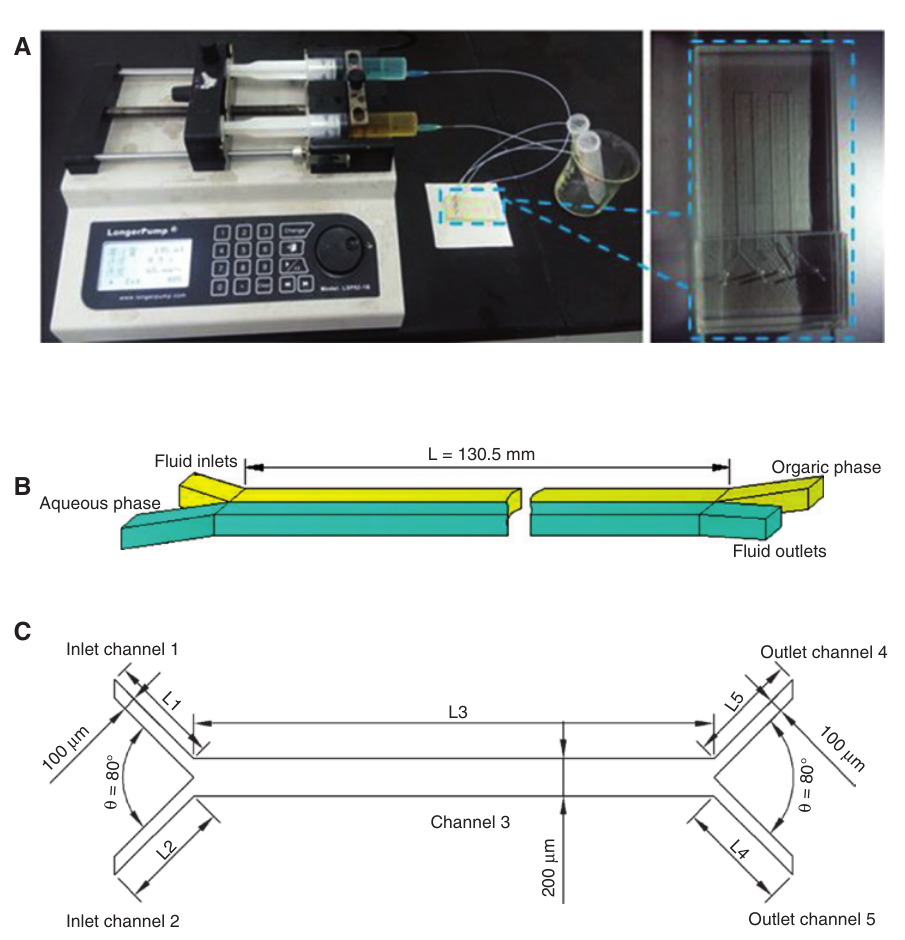
Figure 3: Schematic illustration of the experimental apparatus: (A) diagram of experimental apparatus; (B) and (C) two phases microchan- nel schematic.